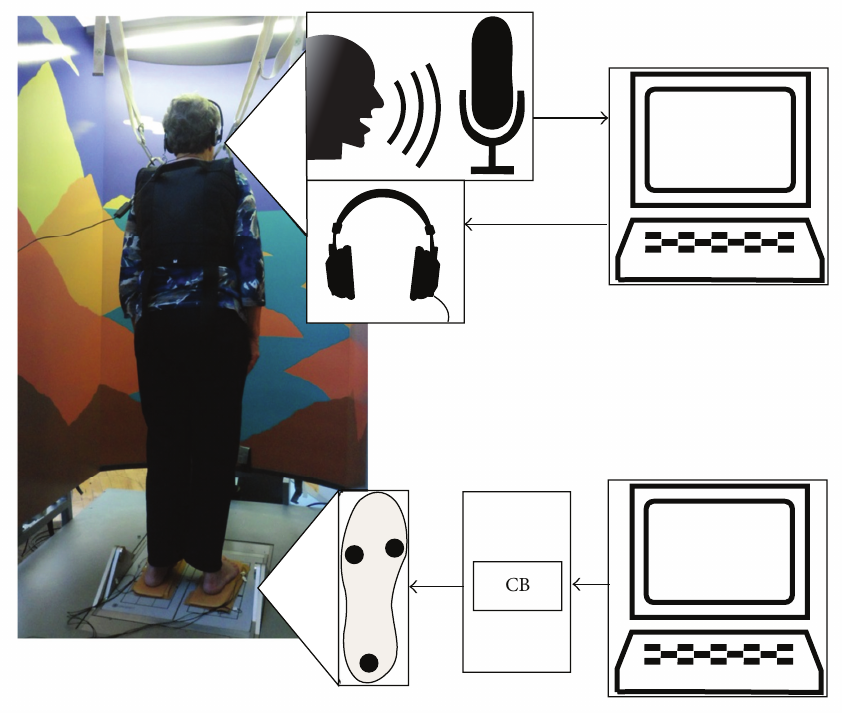
Figure 1: Schematic overview of the experimental setup. Participants received verbal cues to memorize and to recall (1-back task). Custom- made software was used to provide cues and to analyze responses. Vibration was provided via tactor devices embedded in a silicone rubber sole. The soles were connected to a control box (CB) containing the power supply. The control box received commands from custom-made software on a connected computer. Not pictured: A trigger signal from the NeuroCom system was used to initiate stimulus presentation and data collection for the cognitive